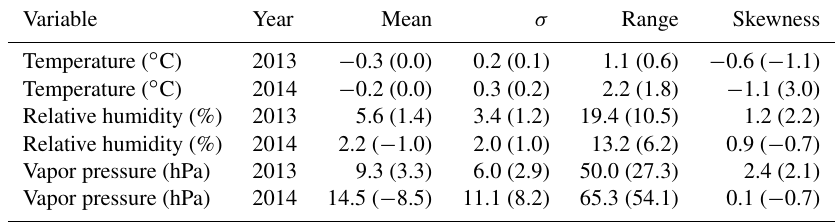
Table 4. Statistics of air temperature and humidity sensor calibration. Eight HOBO sensors were calibrated in 2013 (5–8 April) and 14 sensors in 2014 (15–18 April). For each year the differences in hourly means between each HOBO station and a reference station were calculated; then the differences from all stations were concatenated before calculating the mean, standard deviation, range, and skewness of the distribution. Two reference stations were used: a Rotronic HygroClip2 temperature–RH probe measured by a Campbell data logger and an arbitrarily chosen HOBO station (data in